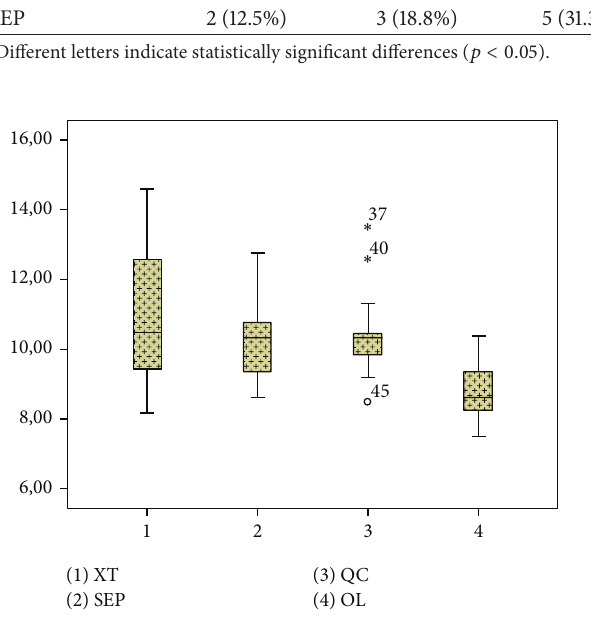
Figure 1: Box-plot, median, and standard deviation of the values of shear bond strength (MPa) in the different adhesive systems and studied